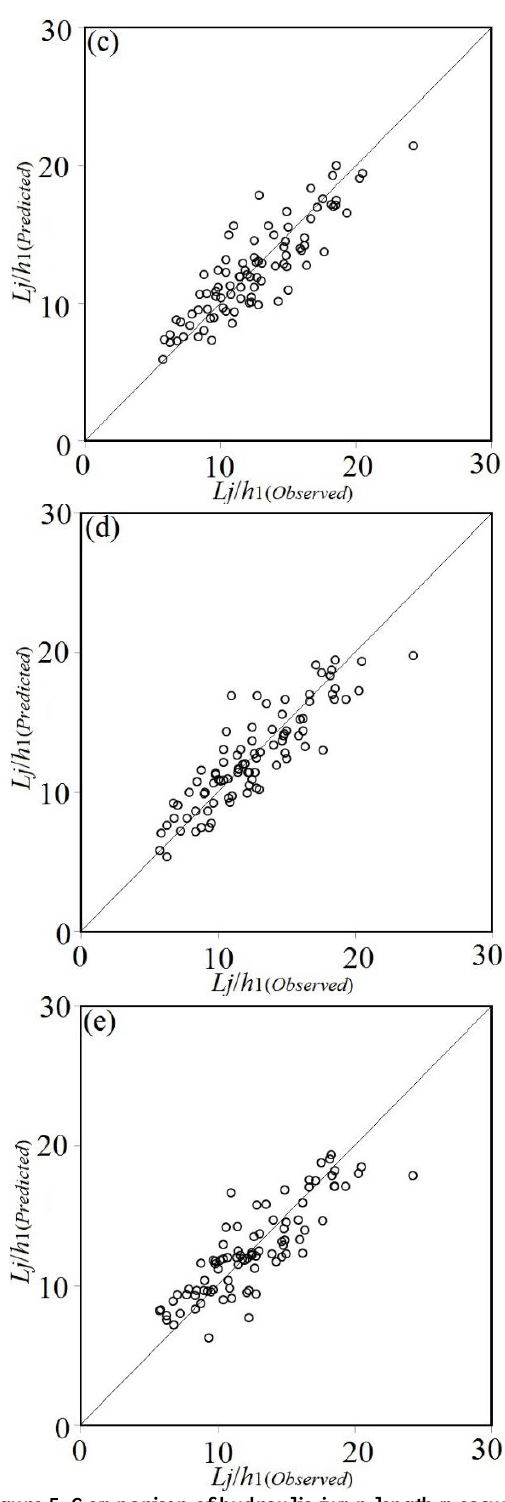
Figure 5. Comparison of hydraulic jump length measured and predicted by a) GEP 1 (b) GEP 2 (c) GEP 3 (d) GEP 4 (e) GEP